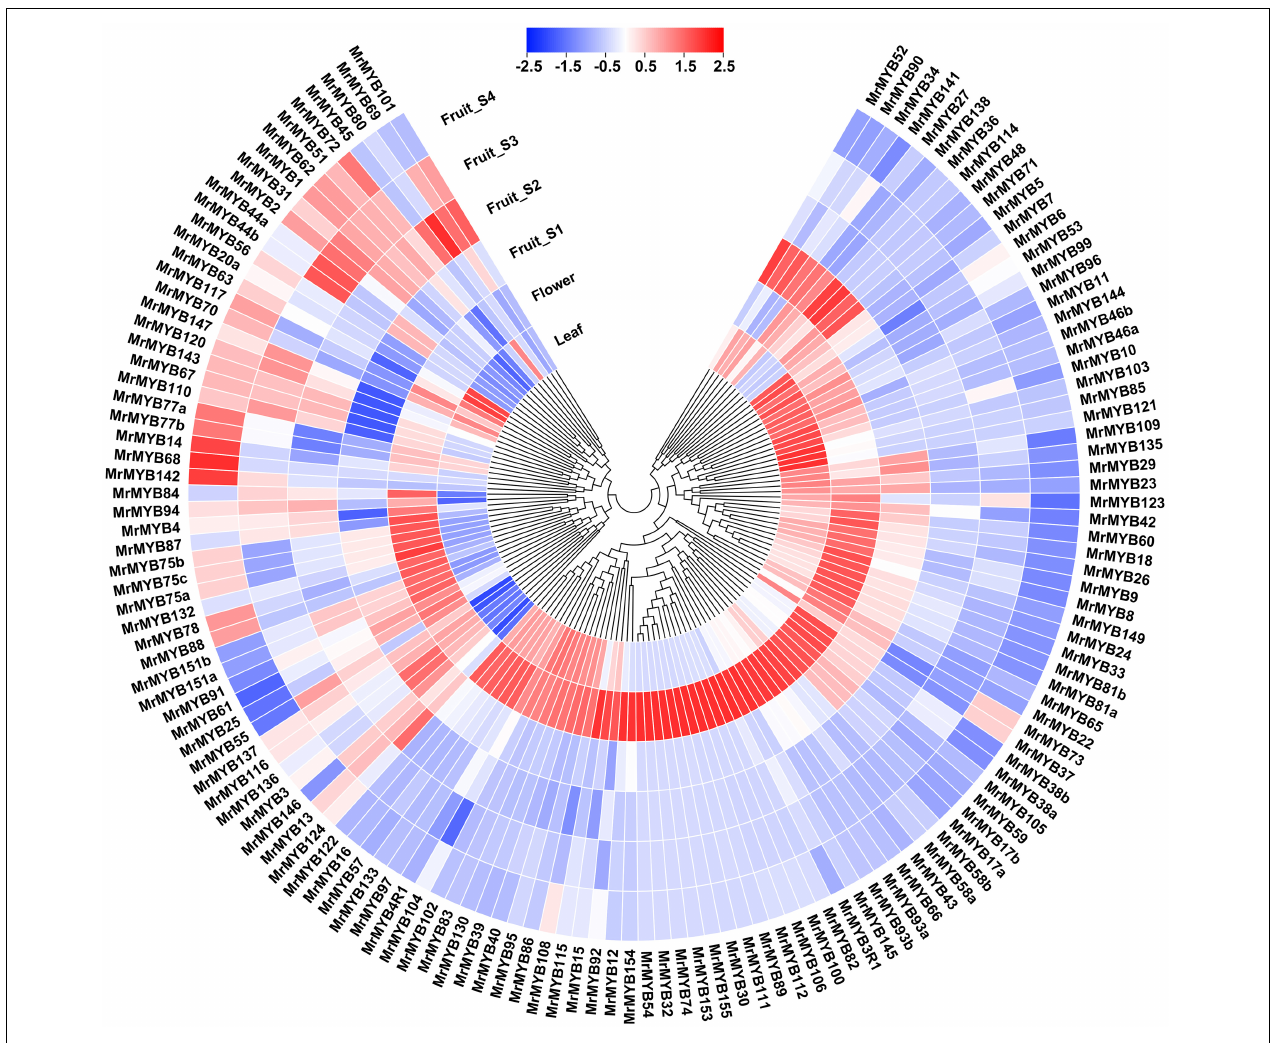
FIGURE 4 | Expression pattern of MrMYB genes in different tissues and during fruit development of Chinese bayberry. The expression pattern was generated based on the FPKM after log2 transformation and analyzed by heatmap hierarchical clustering. The color scale (representing − 2.5 to 2.5) is